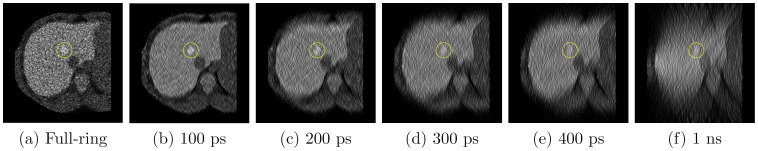
Reconstructed images of Zubal abdomen phantom obtained from TOF-PET data with different timing resolutions.The circle shows the low uptake lesion inside the liver. Note that only the structures inside the ROI are displayed.